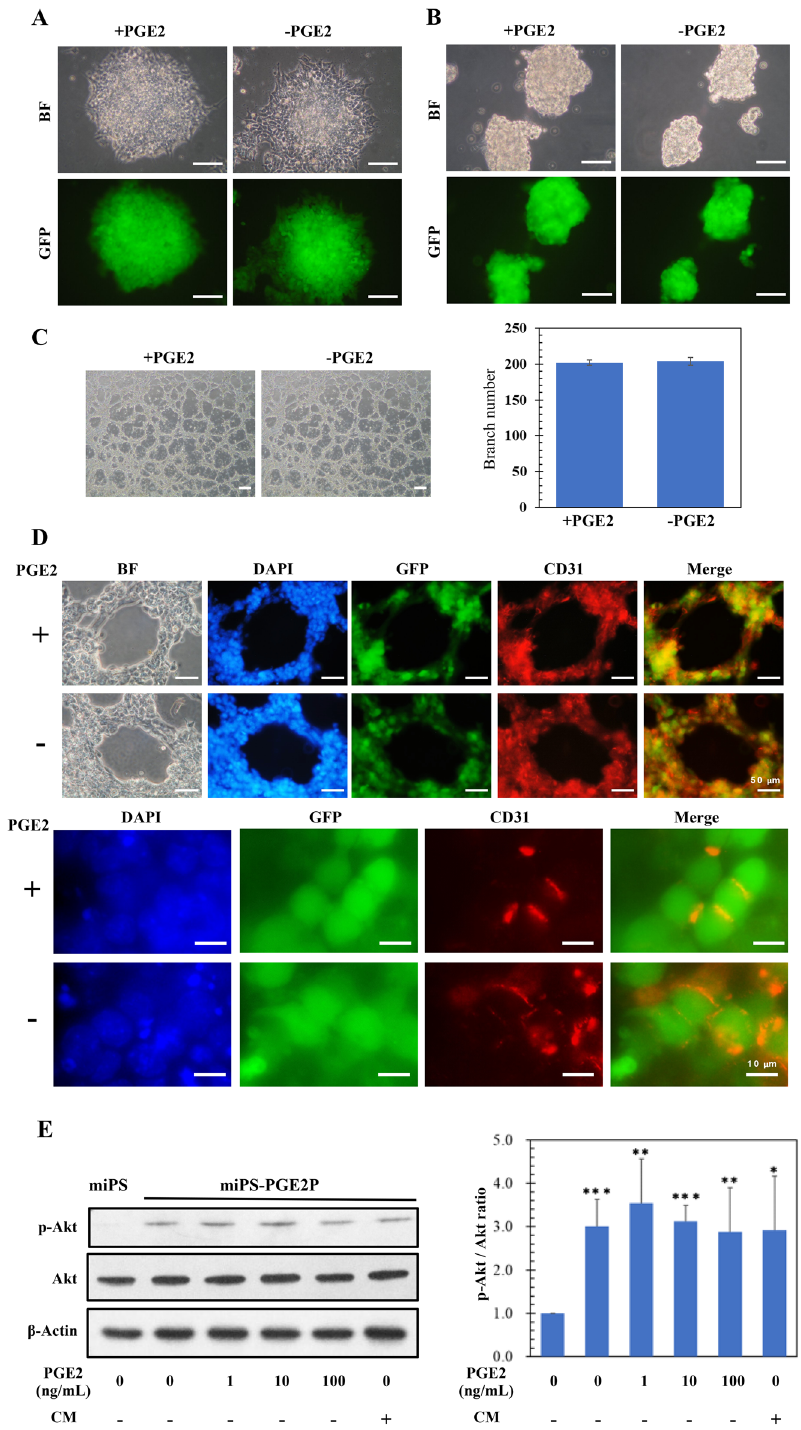
Figure 7. Characterization of miPS-PGE2P cells in the presence or absence of PGE2. ( A ) Adhesive culture. Scale bar 100 µm. ( B ) Non-adhesive culture. Scale bar 100 µm. ( C ) Tube formation assay (left). Scale bar 100 µm. Branching point analysis by ImageJ. (right) Data are plotted as means ± SD. There was no significance between the data. ( D ) Immunofluorescent analyses of tubes in C. BF, bright field. DAPI, staining for nucleus. GFP, fluorescence of GFP. CD31, staining with anti-CD31 antibody labelled with Alexa fluor 555. Scale bars 50 µm (top) and 10 µm (bottom). ( E ) Western blotting analysis of the phosphorylation of Akt. A representative blot is shown at left. Densitometric analysis of the blots from three independent experiments by ImageJ is shown at right. Data are plotted as means ± SD. * p < 0.1, ** p < 0.05, *** p <